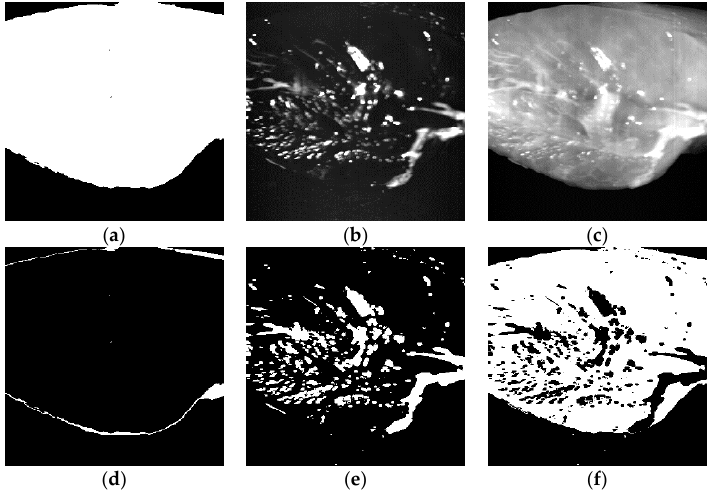
Figure 2. The main steps of image segmentation. ( a ) Whole meat mask (band 695–band 422); ( b ) Lowest reflectance image (band 422); ( c ) Highest reflectance image (band 695); ( d ) Irregular shadow mask; ( e ) Specular reflection or fat mask; ( f ) Muscle tissue mask to be used as the region of interest (ROI).